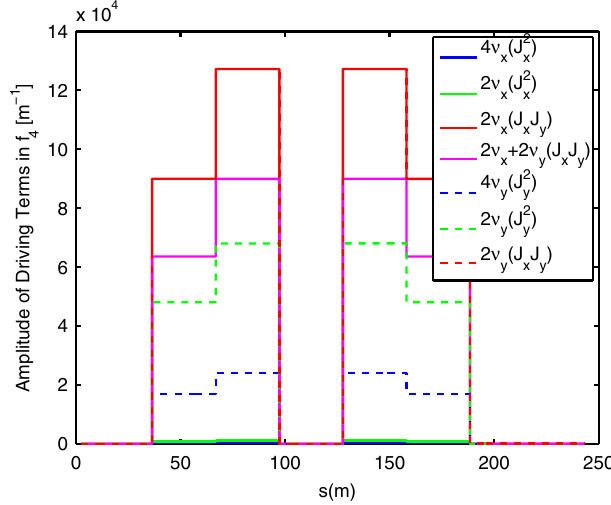
FIG. 7. The canceled fourth-order resonance terms driven by a family of the sextupoles as they accumulated in the PEP-X achromat.